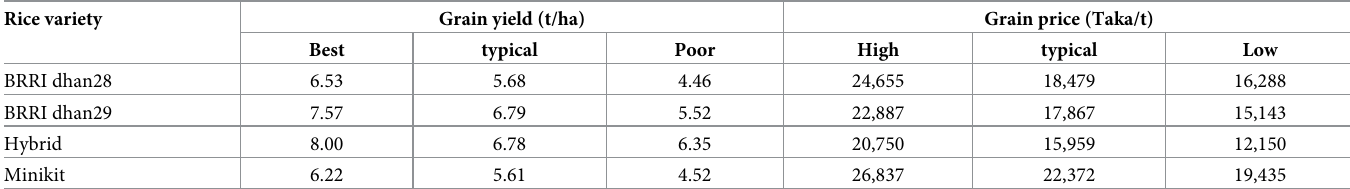
Table 7. Seasonal variability (2015–16 and 2016–17) in actual yield and price of BRRI dhan28, BRRI dhan29, Hybrid and Minikit. Rice variety Grain yield (t/ha) Grain price (Taka/t) Best typical Poor High typical